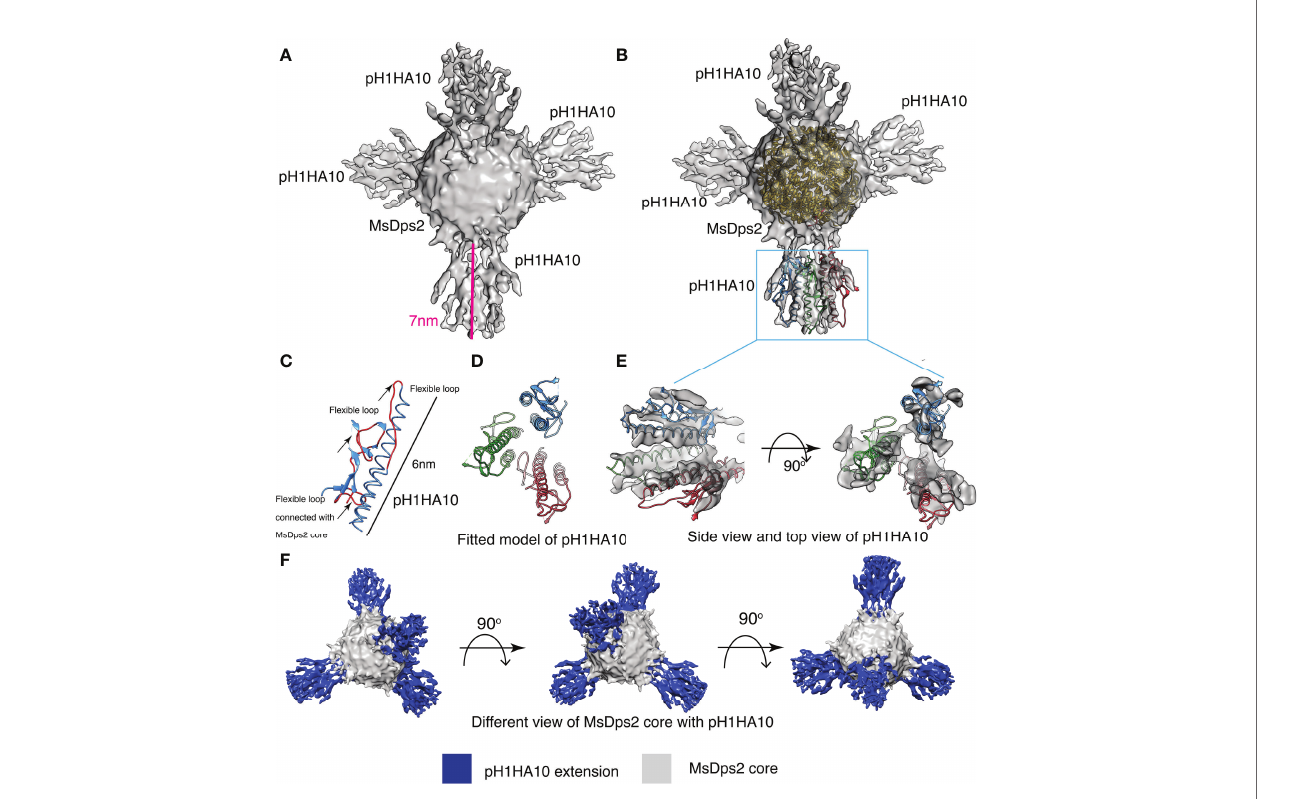
FIGURE 4 | Cryo-EM structure of MsDps2-pH1HA10: (A) Solid representation of cryo-EM reconstruction of MsDps2-pH1HA10 shows four pH1HA10 extensions from MsDps2 core. Length of the pH1HA10 with linker is highlighted with a pink scale bar and length is 7 nm. (B) MsDps2 crystal structure (2Z90) is docked into the transparent view of the core region of MsDps2-pH1HA10. The pH1HA10 trimeric structure is fi tted into the extended region of the cryo-EM map. (C) Modelled structure of pH1HA10 protomer. Flexible loops are shown in red. Dimension of pH1HA10 model structure is calculated to be 6 nm. (D) Top view of modelled structure of pH1HA10 trimer. (E) Side and top view of the transparent cryo-EM map of pH1HA10 trimeric extension. The protomers in pH1HA10 trimers are shown in blue, red and green respectively. (F) Different views of re fi ned 3-D cryo-EM map of MsDps2- pH1HA10. pH1HA10 extension is shown in blue and MsDps2 core is shown in